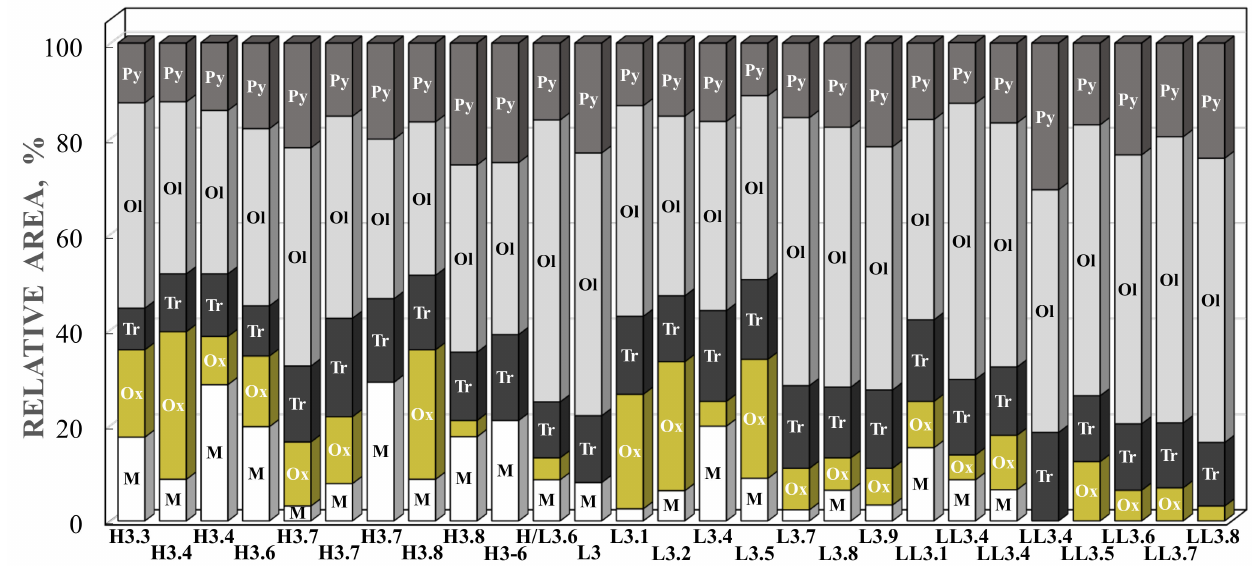
Figure 36. Modal analysis of the phase composition (relative iron fractions) using the relative areas of components revealed in the Mössbauer spectra of selected unequilibrated ordinary chondrites. (cid:3) —Fe-Ni alloy ( M ), —ferric compounds ( Ox ), (cid:4) —troilite ( Tr